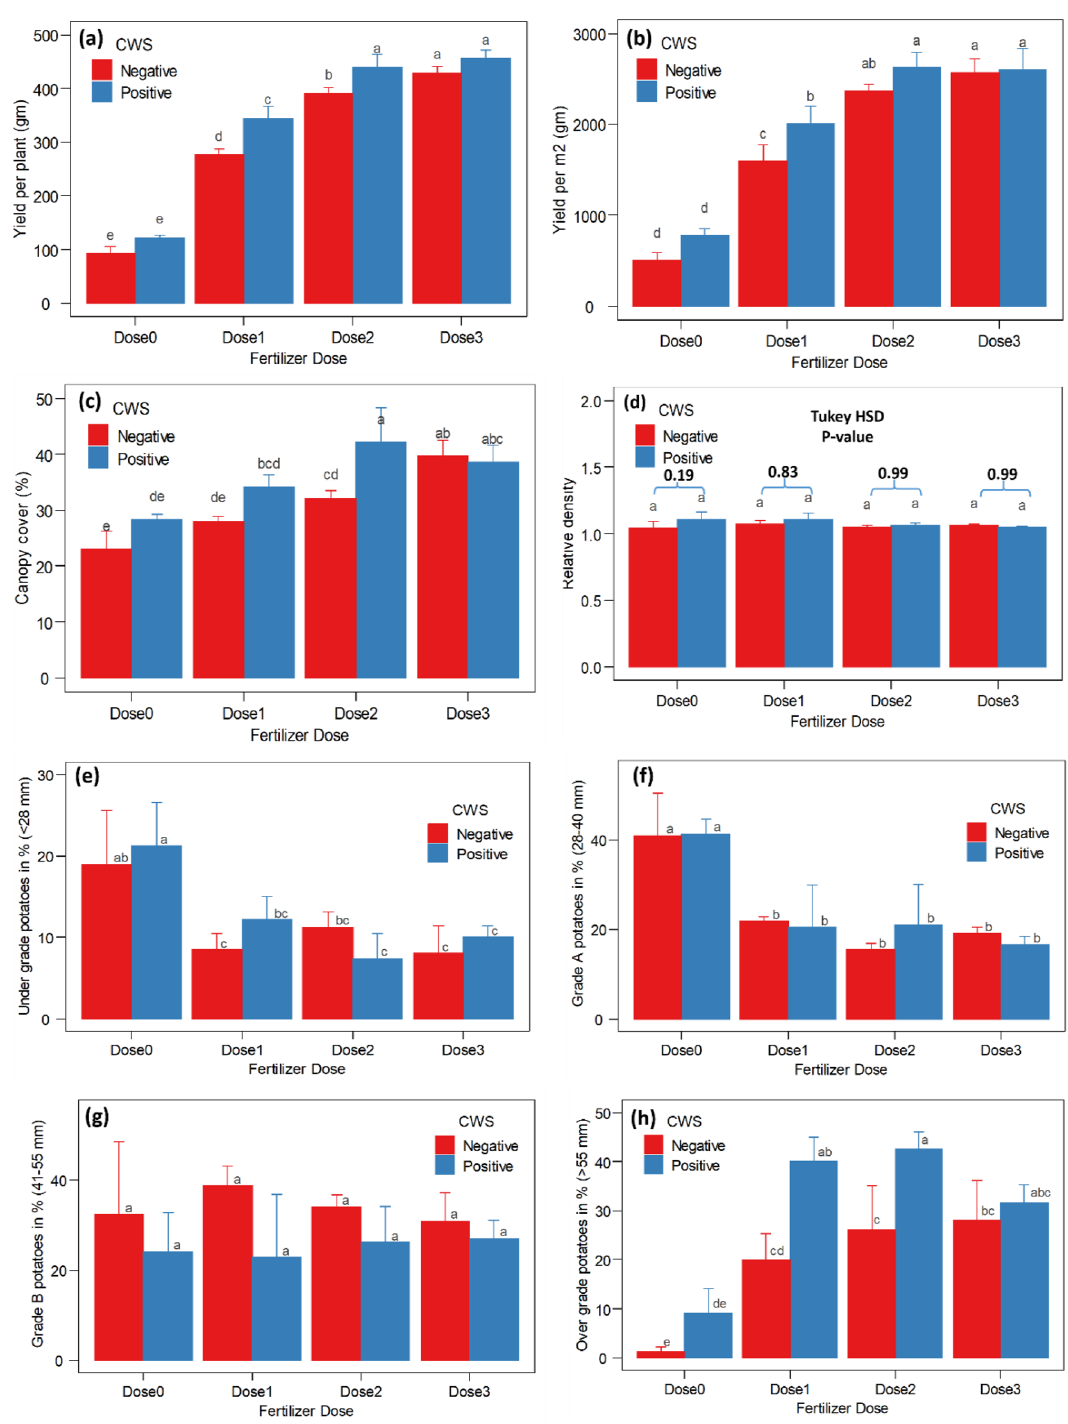
percentage. ( g ) Grade B potato percentage. ( h ) Over–grade (industrial-grade) potato percentage. ( ns p ≥ 0.05, * p < 0.05, ** p < 0.01, *** p < 0.001), data are means ± SD ( n = 4). Bars without shared letters indicate significant